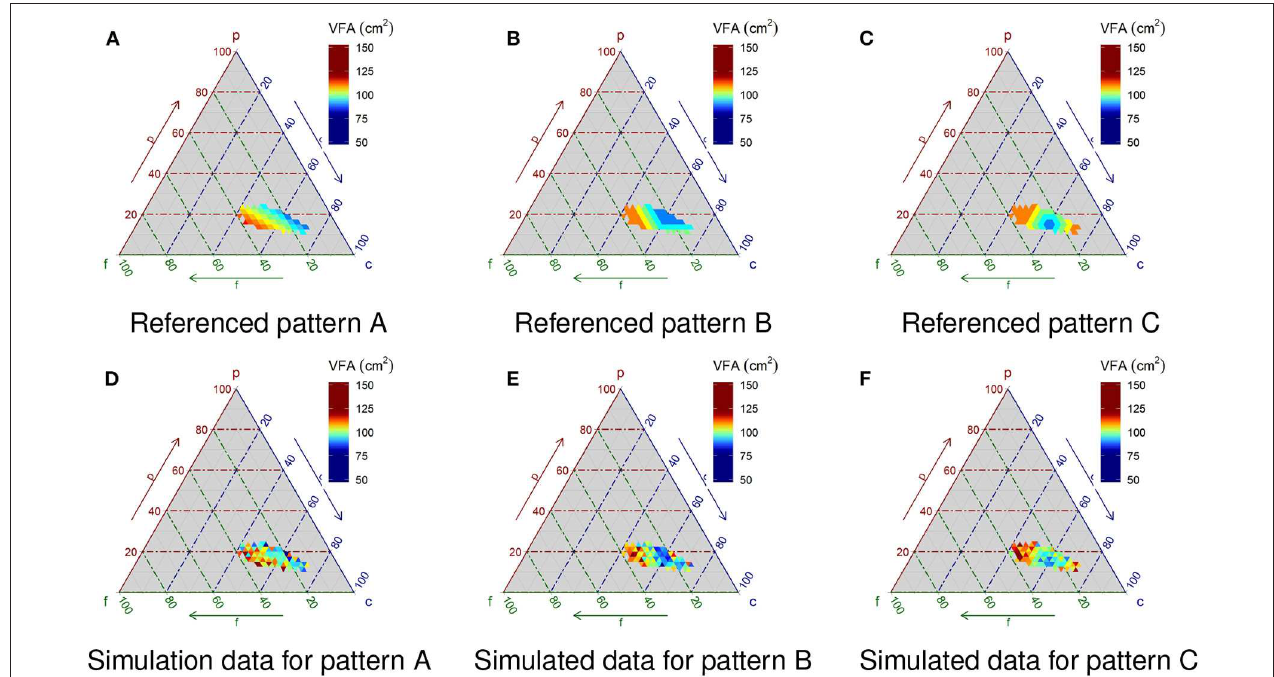
FIGURE 3 | Simulated pattern of VFA and simulated data. Pattern A is defined as a higher %P to %F ratio, decreasing VFA. Pattern B is defined as < 27.5%F and more than 12.5%P, meaning visceral fat does not accumulate. Pattern C is defined by an optimum point for lower VFA in terms of %P:%F:%C as15%:25%:60%, respectively. (D–F) Are examples of simulated data with Gaussian noise corresponding to (A–C) ,